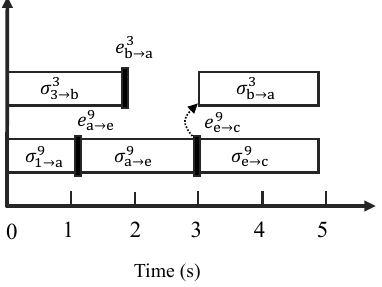
Figure 8. Calendar: the process of two vehicles passing through an intersection.